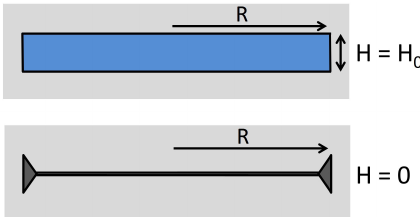
Figure 1. Cross-section of a narrow circular slit pore with radius R and width H 0 is embedded in a soft solid filled with condensate at saturation pressure ( m = 1). At low values of m , the slit is completely compressed ( H = 0) and degenerates to a closed dislocation loop. The dark triangles symbolize the cross-section of the dislocation core, where the solid material is strongly compressed. Connections to larger pores or to the ambient vapor outside the porous solid are not